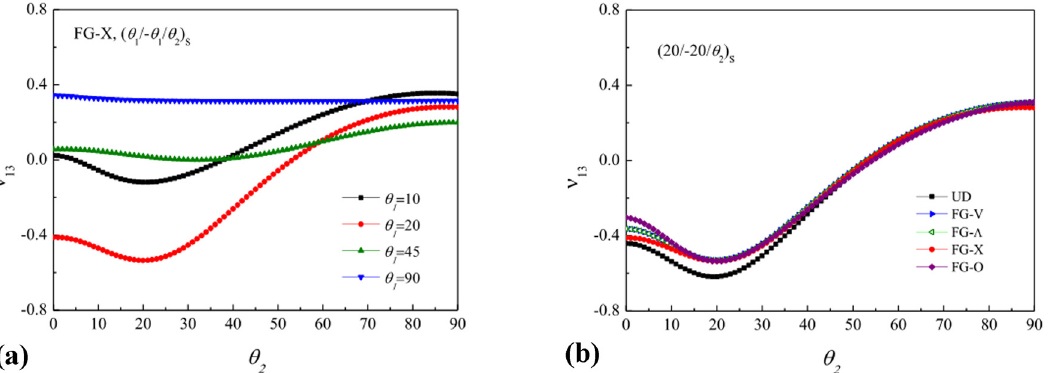
Figure 4: The relationship between the e ff ective Poisson ’ s ratios ν 13 and the lamination angles θ 2 [ 81 ] . ( a ) Di ff erent lamination angles, ( b ) di ff erent distribution